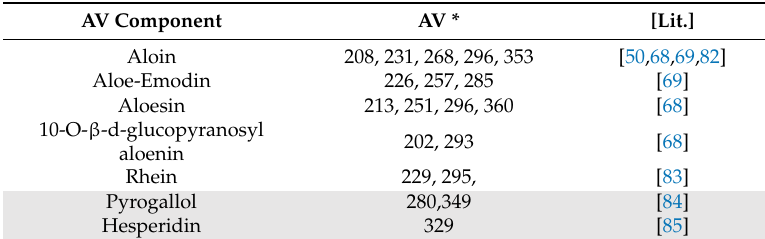
Table 4. UV-vis absorption signals of sample AV in